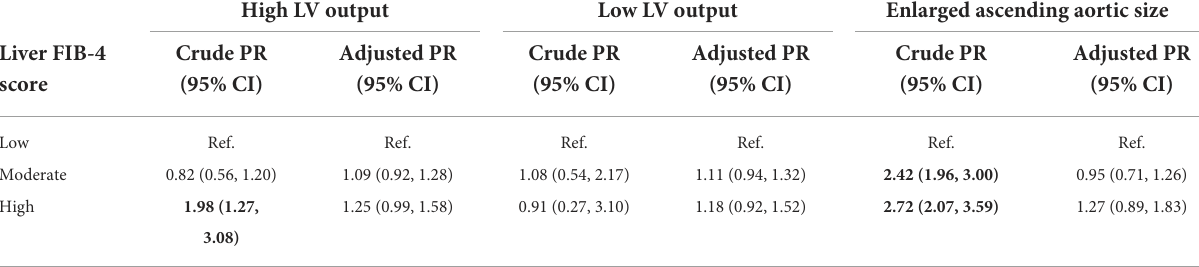
TABLE 5 Multivariable-adjusted prevalence ratio of abnormal LV output and ascending aortic enlargement in hepatic fibrosis * . High LV